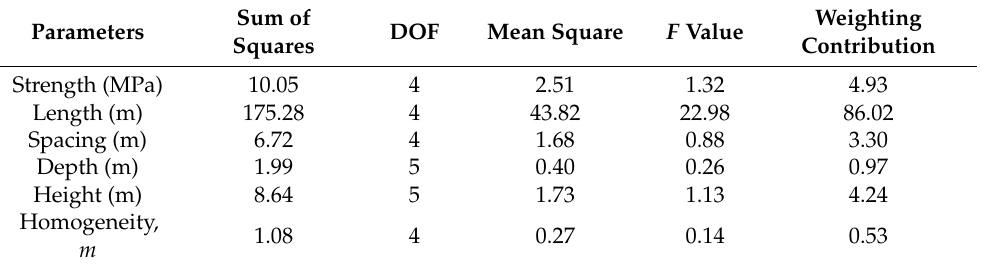
Table 3. Summary of ANOVA for peak shear displacement.